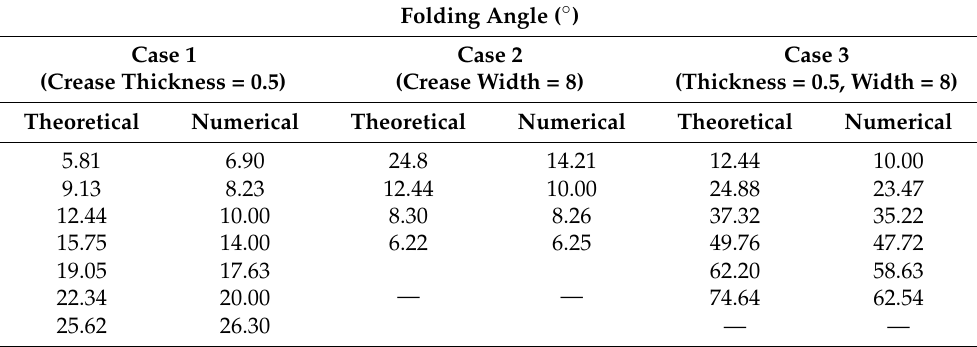
Figure 7 indicates the folding configurations of the origami microgrippers with